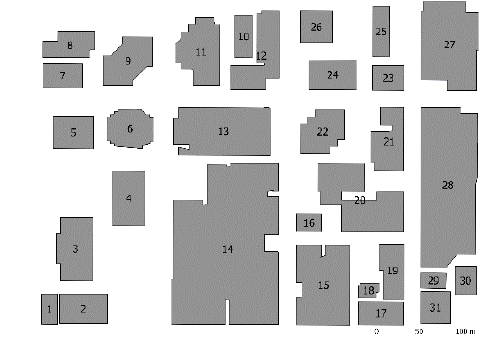
Figure 7. Results of the building outline regularization for the Toronto test area.